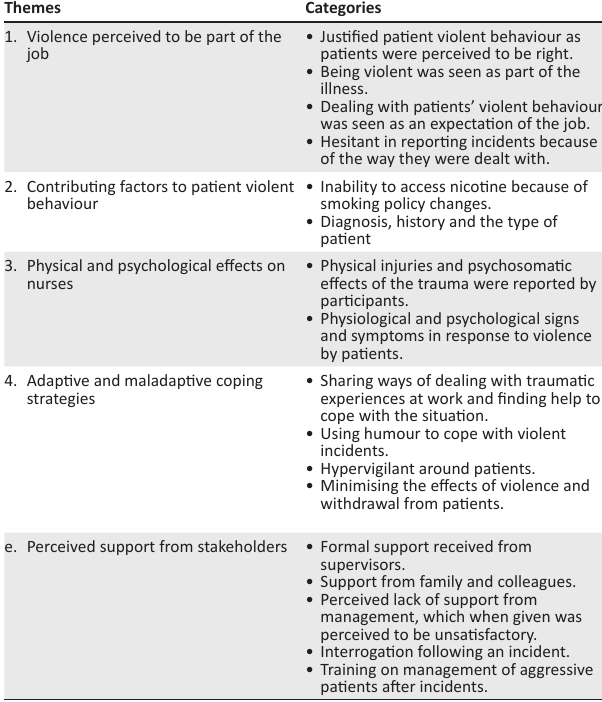
TABLE 2: Participant themes and